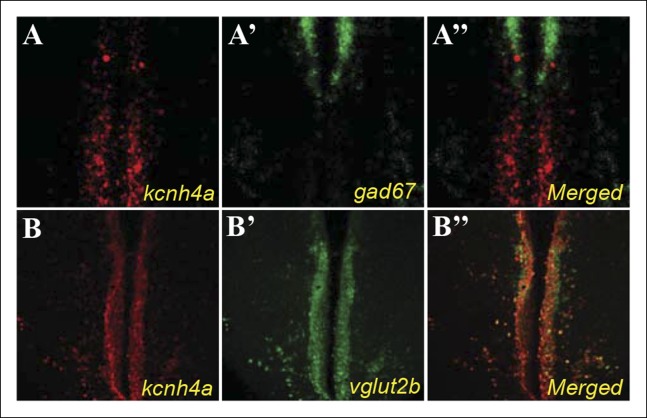
Hypothalamic kcnh4a-expressing neurons are glutamatergic.Double in-situ hybridization against kcnh4a (red, A, B) and gad67 (green, A'), or vglut2b (green, B'). All pictures are on a single optical plane of 0.5 µm.